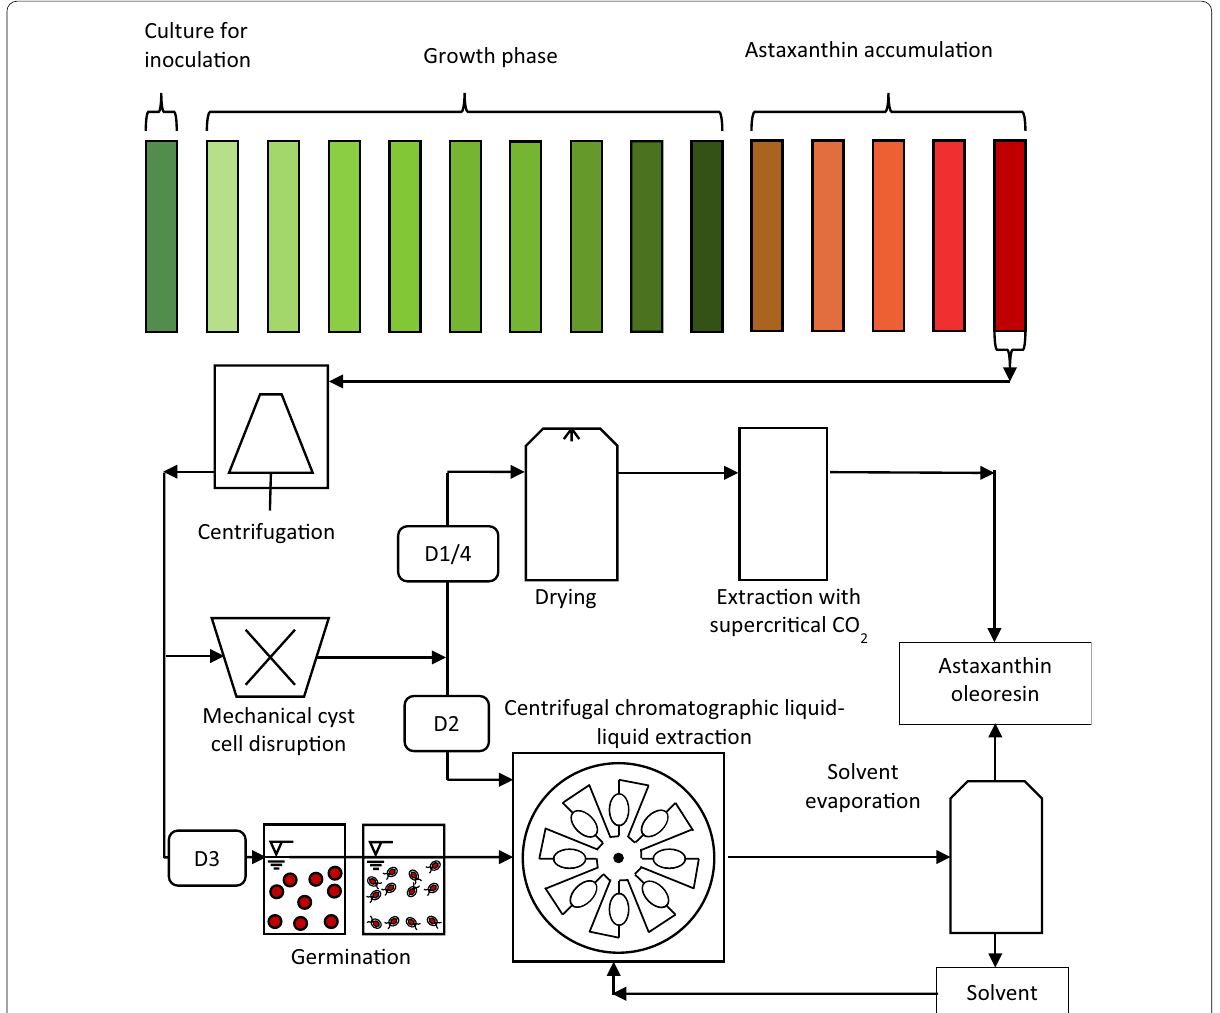
Fig. 1 Schematic presentation of the biotechnological production of H. pluvialis , including centrifugation, mechanical cyst cell disruption, drying and a supercritical CO 2 extraction performed in-house (D1) and by an external service provider (D4), as well as liquid–liquid chromatographic extraction of astaxanthin from mechanical disrupted cyst cells (D2) and germinated zoospores (D3) into ethyl acetate, and a subsequent solvent evaporation